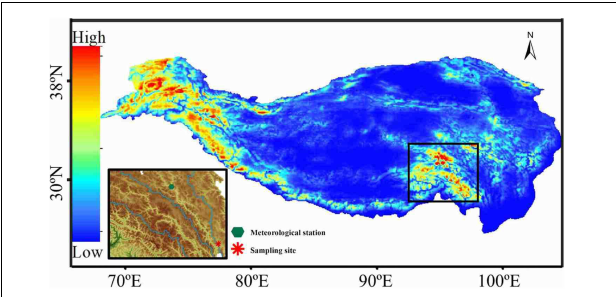
FIGURE 1 | The snow cover distribution and the locations of tree-ring sampling site and meteorological station in this study. The map on the right shows the snow cover on the Tibet Plateau derived by Yan et al. (2021). Blue represents the low snow cover, and red represents the high.